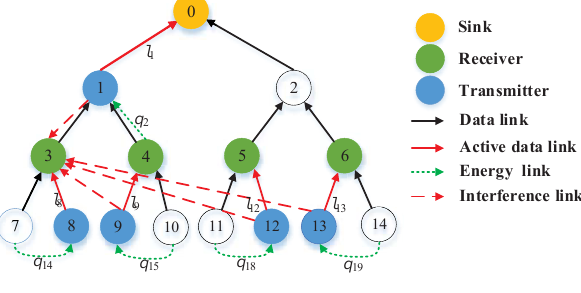
Figure 1. Interference channel model of data flows with the half-duplex